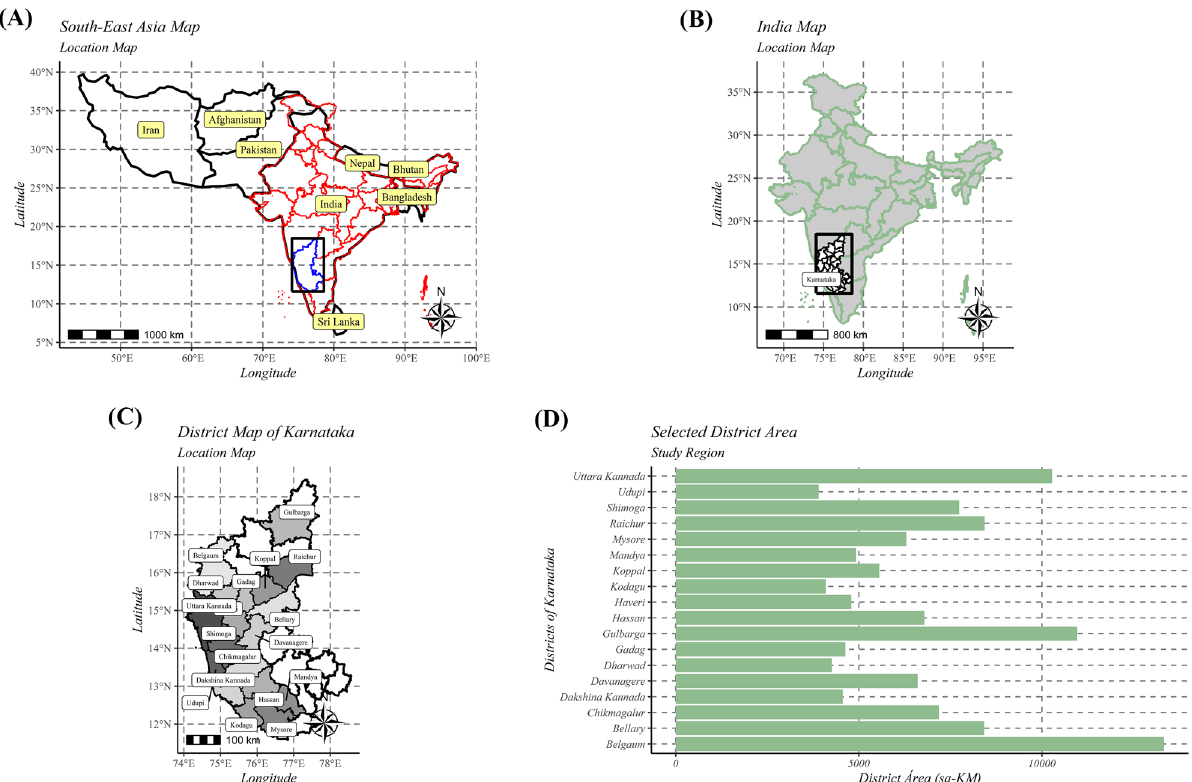
Figure 1. Featured map of South-East Asia ( A ), India ( B ), and Karnataka ( C ). A total of 18 administrative districts of Karnataka were considered to gather data on rice blast disease. The area of different districts under study is shown ( D ). The maps were created using R software (version